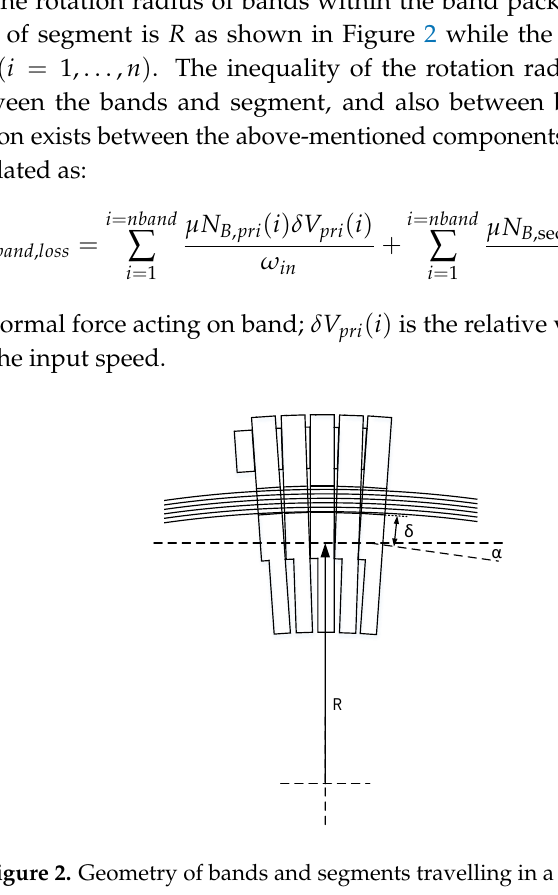
Figure 2. Geometry of bands and segments travelling in a wrap